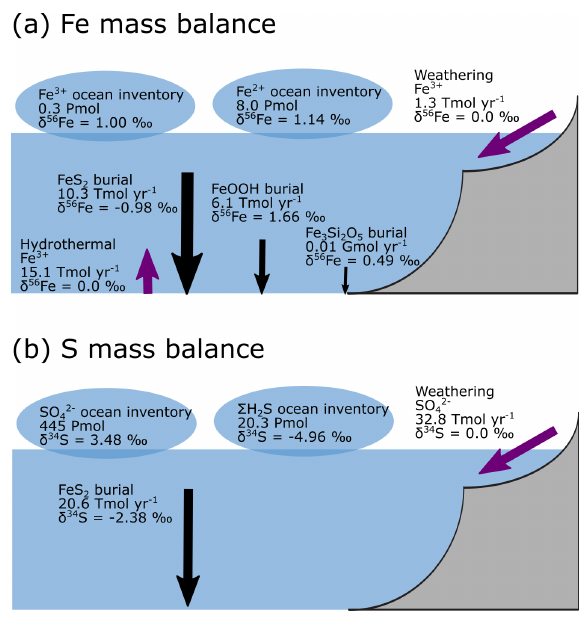
Figure 10. Isotope mass balance for the (a) 56 Fe and (b) 34 S sys- tems from our baseline simulation. Purple arrows are influxes, and black arrows are outfluxes. Bubbles represent the whole ocean in- ventory. Note that in our simulation, the S system is not in steady state (because FeS 2 burial is too